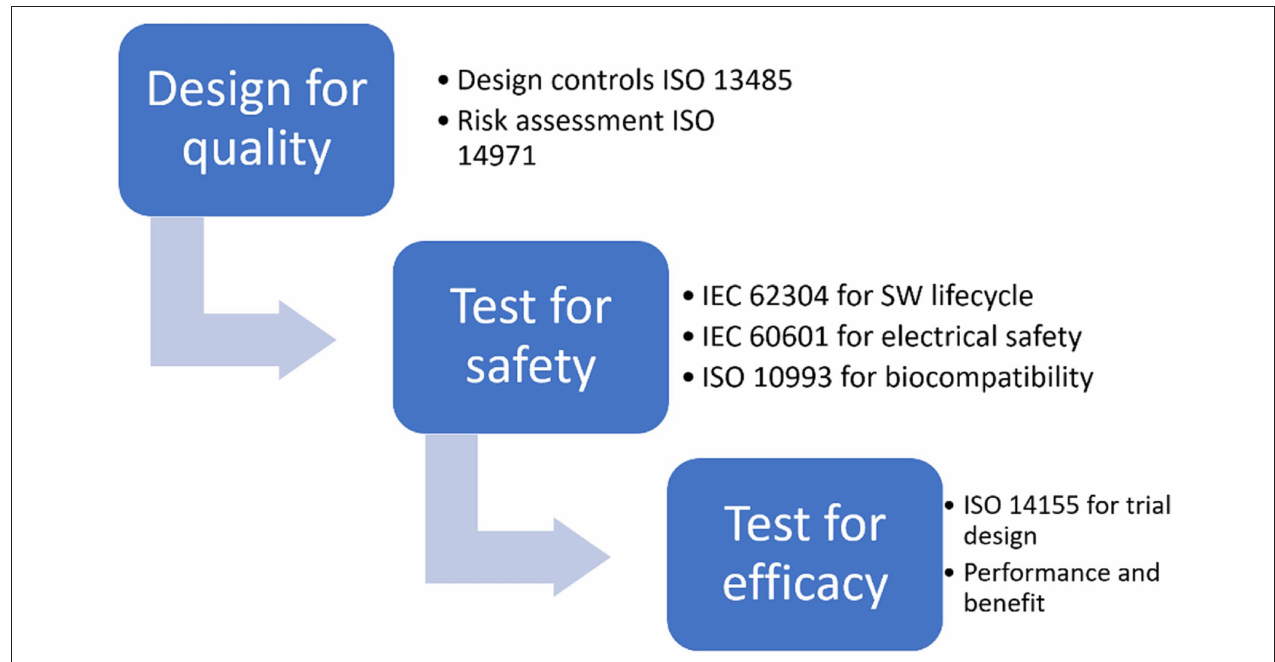
FIGURE 1 | Risk based approach for CE